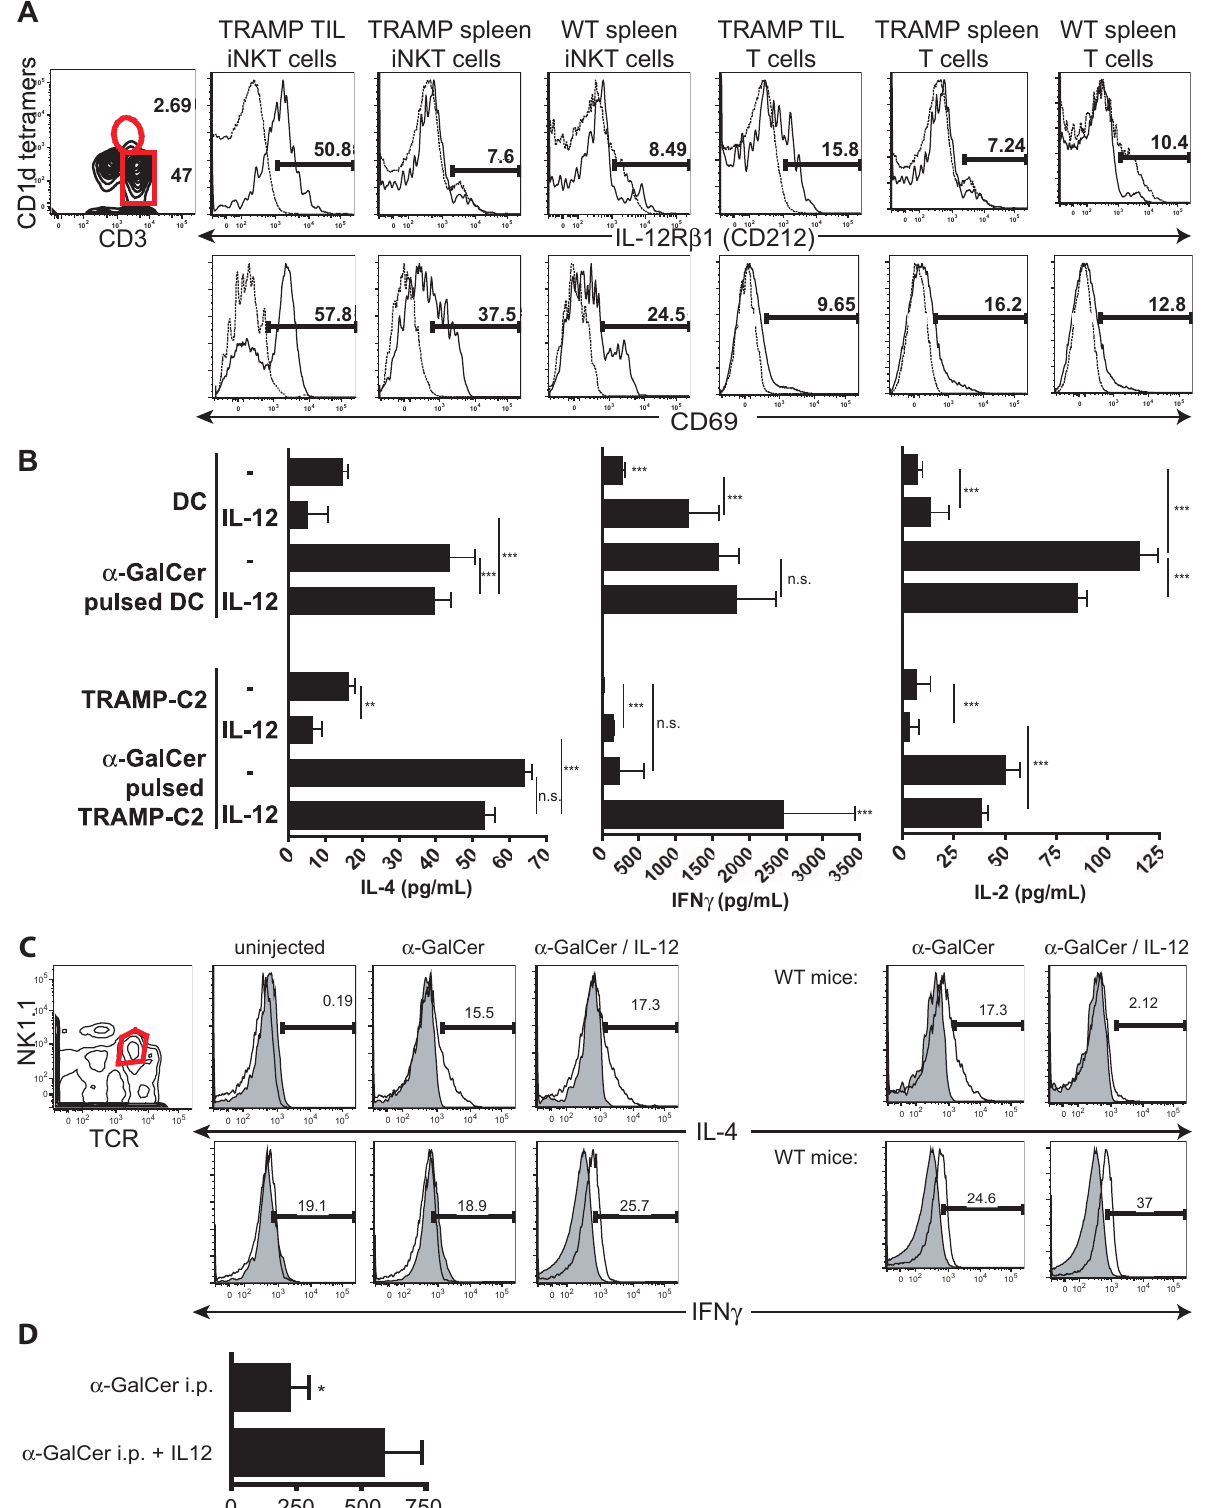
Figure 5. IL-12 combined with a -GalCer restores the ability to activate iNKT cells in response to prostate tumor cells. A. IL12R b 1 expression on TIL-iNKT and T cells from primary TRAMP prostate tumors, TRAMP spleen and WT spleen ex vivo . Contour plot shows presence of iNKT (CD3 + CD1d tetramer + ) and T cells (CD3 + CD1d tetramer 2 ) from TRAMP prostate tumors, gated on CD45 + TIL. Data shown are representative of 2